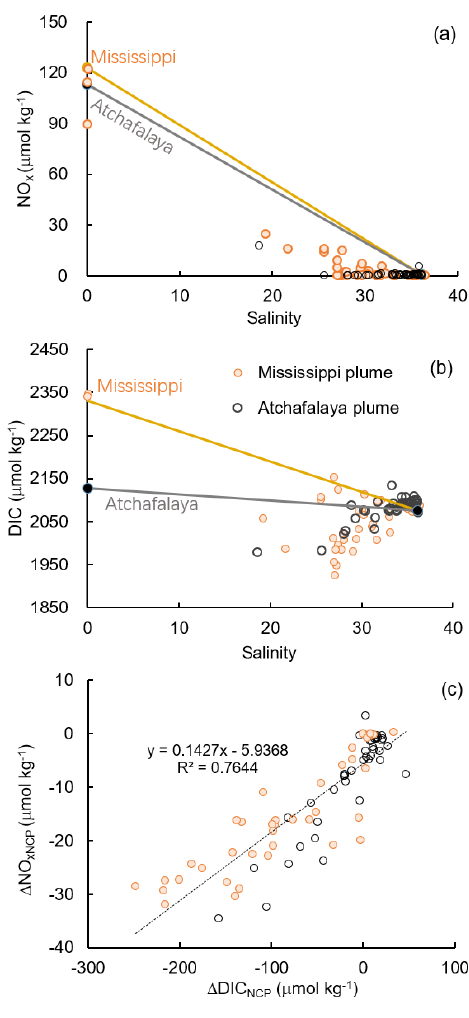
Figure 8. Scatter plots of (a) DIC and salinity, (b) NO x and salinity, and (c) the non-conservative changes in DIC ( (cid:49) DIC NCP ) and NO x ( (cid:49) NO x NCP ) in the Mississippi and Atchafalaya plumes. The end- member concentrations of the Mississippi River, the Atchafalaya River, and offshore gulf surface water are shown in (a) and (b) to- gether with the conservative mixing